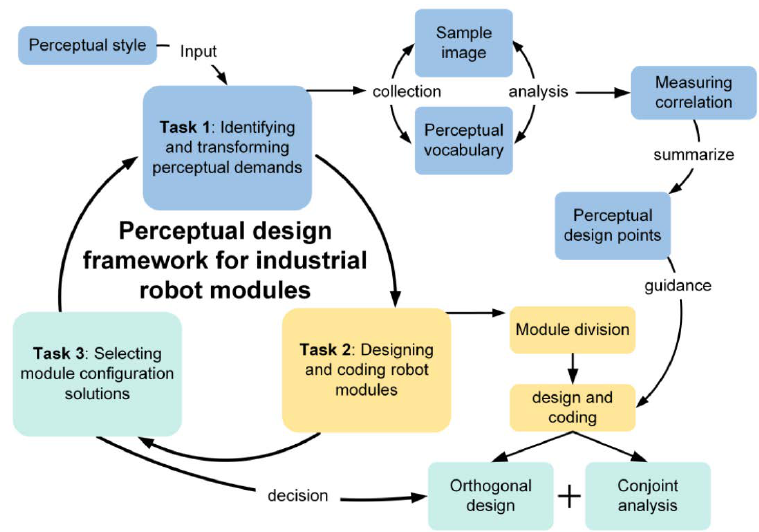
Figure 1. Perceptual design framework of an industrial robot